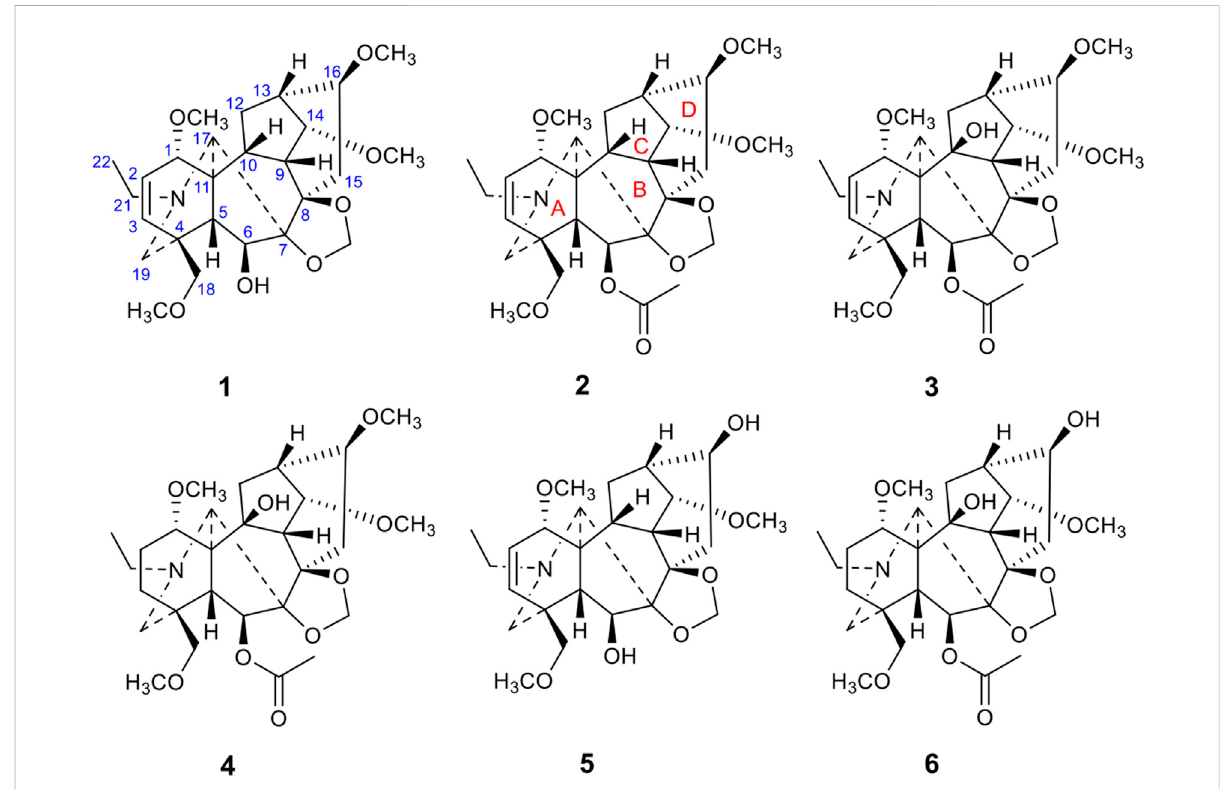
FIGURE 1 The chemical structures of six new diterpenoid